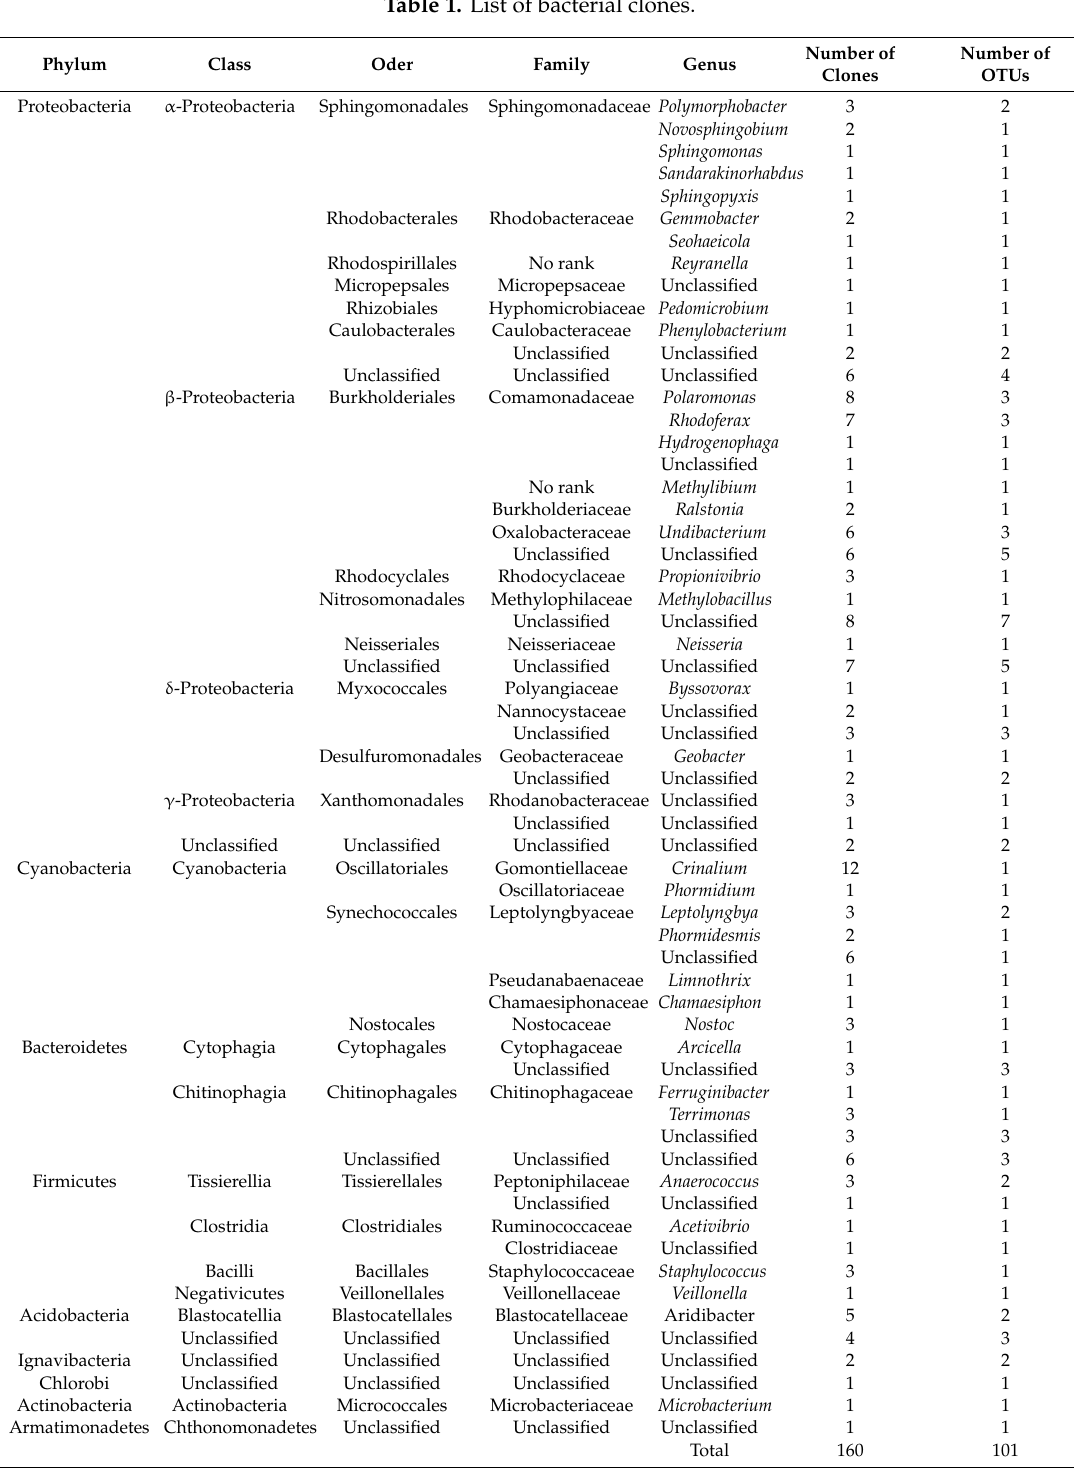
Table 1. List of bacterial